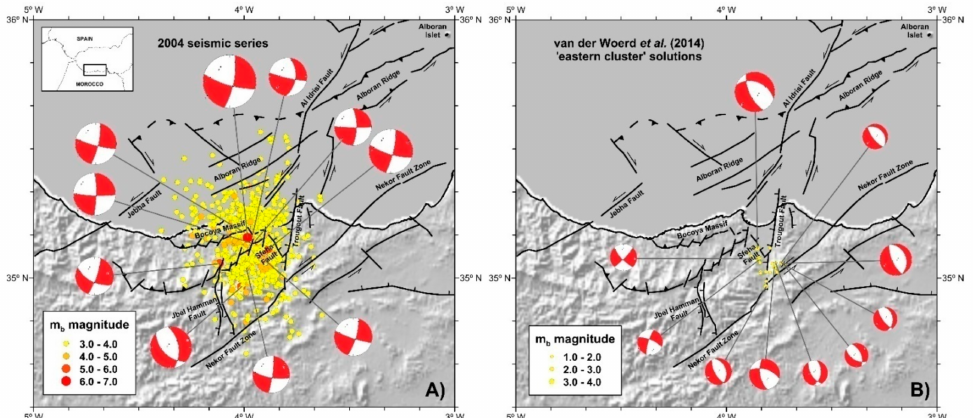
Figure 5. ( A ) 2004 seismic sequence showing earthquakes with magnitude above 3.0 and computed focal mechanisms for the biggest events. ( B ) Earthquakes with magnitude above 1.0 and focal mechanism solutions for the biggest events (m b 1.9–3.0) of the “eastern cluster” studied by